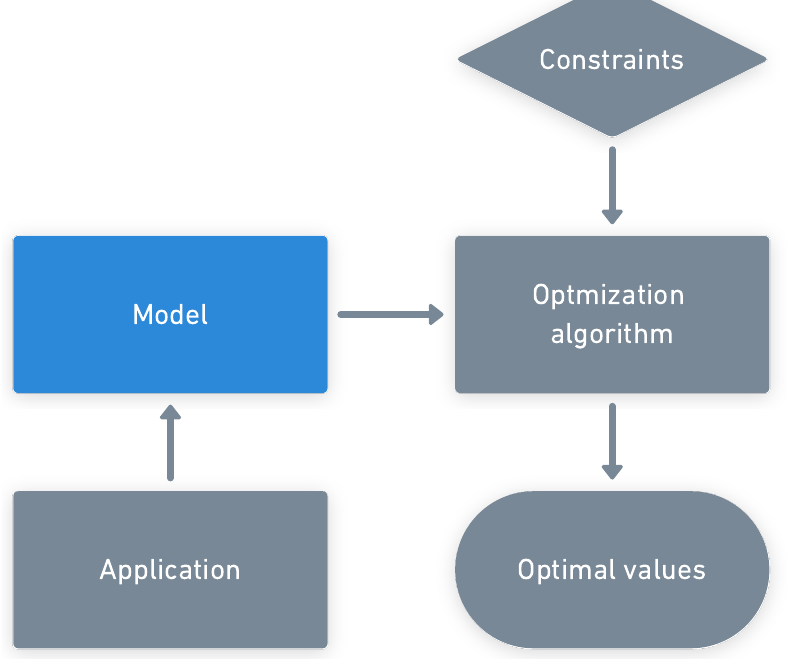
Figure 14. Optimization workflow showing how DVFS and DPM optimization could be implemented from ou